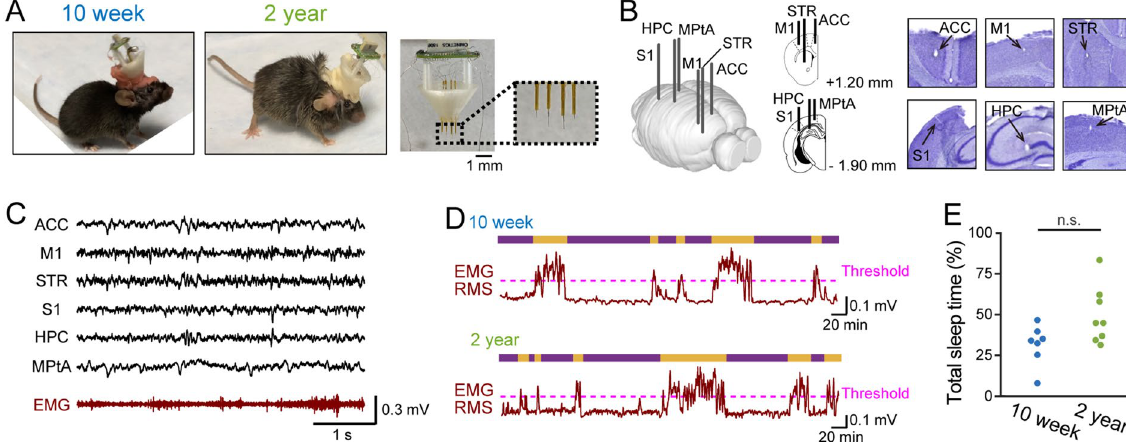
Figure 1. Multisite LFP recordings and definition of sleep states in aged mice . ( A ) (Left) A 10-week and 2-year mouse implanted with an electrode array. (Right) A custom-made electrode array. The dotted box is magnified in the right inset, showing electrodes protruding from the electrode assembly with a length of 0.5–2.3 mm to be inserted into the brain. ( B ) (Left) Electrodes implanted into six brain regions. (Right) Histological confirmation of an electrode in each region. ( C ) Representative LFP signals recorded from the six brain regions (black) and an EMG signal (brown). ( D ) The RMS (magnitude) of EMG signals in 10-week (top) and 2-year (bottom) mice. The magenta dotted lines represent the detection thresholds. The upper bars represent sleep (purple) and awake (orange) states. ( E ) The percentage of sleep periods defined from EMG signals to total recording periods ( n = 7 and 8 mice). Each dot represents an individual mouse. * P < 0.05, Mann–Whitney U test. MATLAB R2021b (https:// jp. mathw orks. com/ produ cts/ new_ produ cts/ relea se202 1b. html) and Illustrator 26.2.1 (https:// www. adobe. com/ jp/ produ cts/ illus trator. html) were used to create this